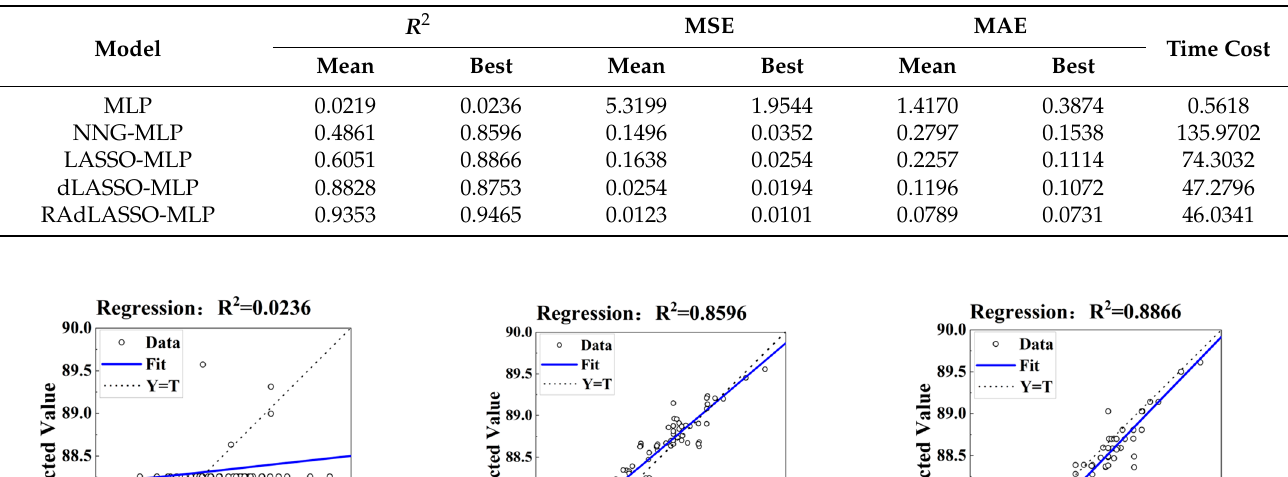
Table 5. Results of RON estimation with different algorithms.